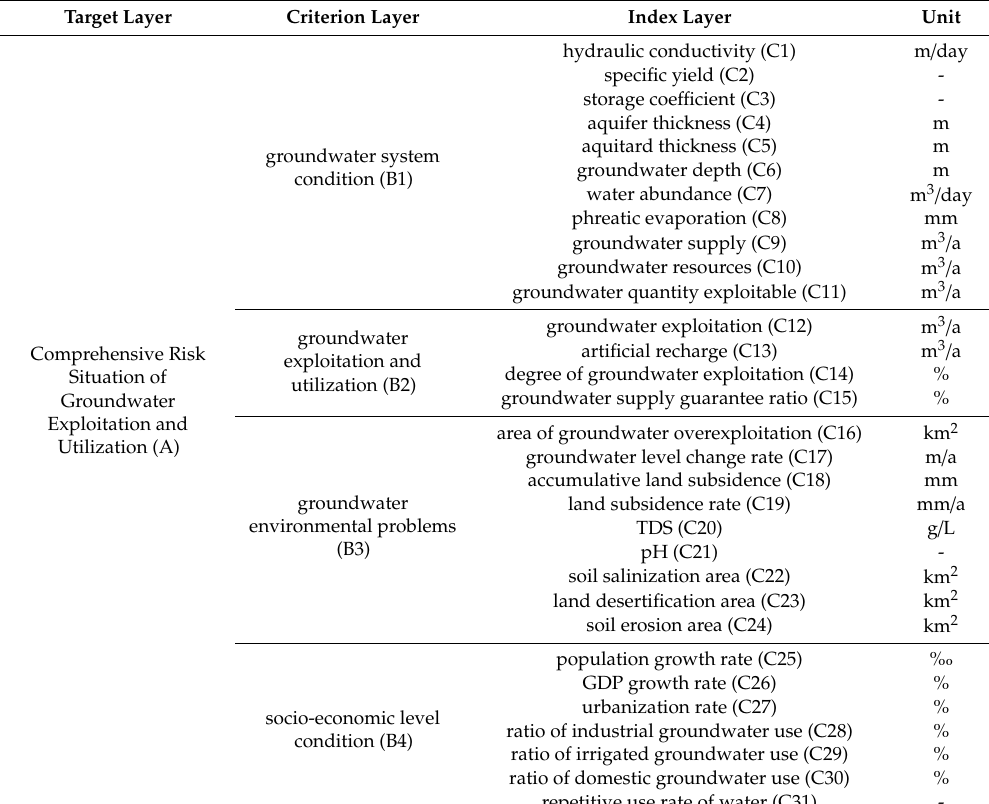
Table 3. Risk evaluation index system for groundwater exploitation and